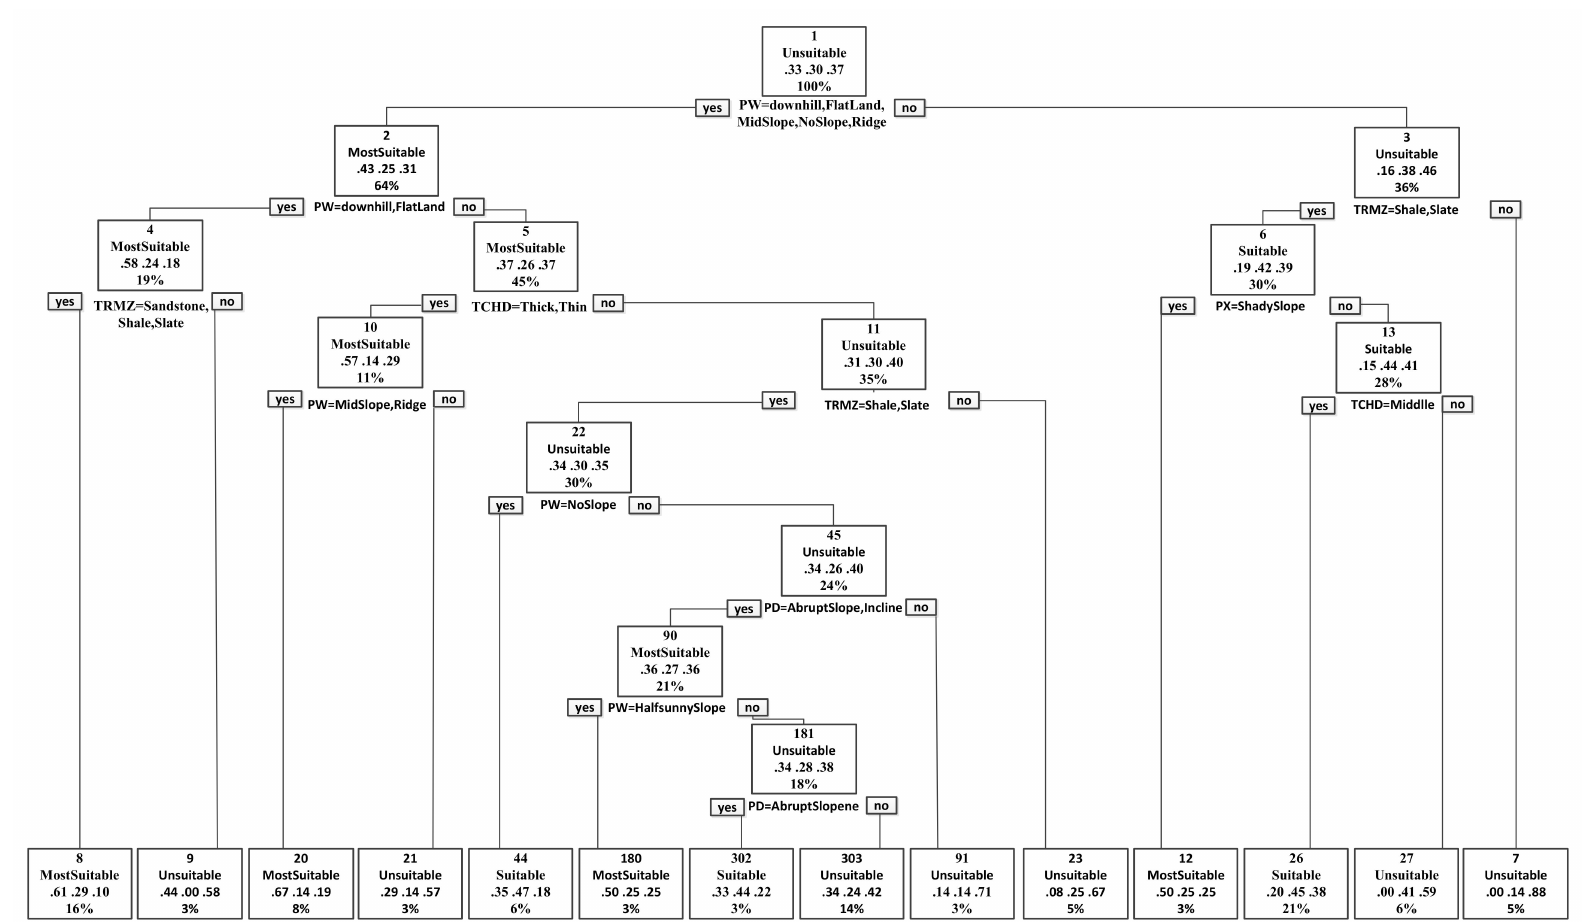
Figure 5. Classification decision tree model of tree suitability for certain forest site conditions of Masson